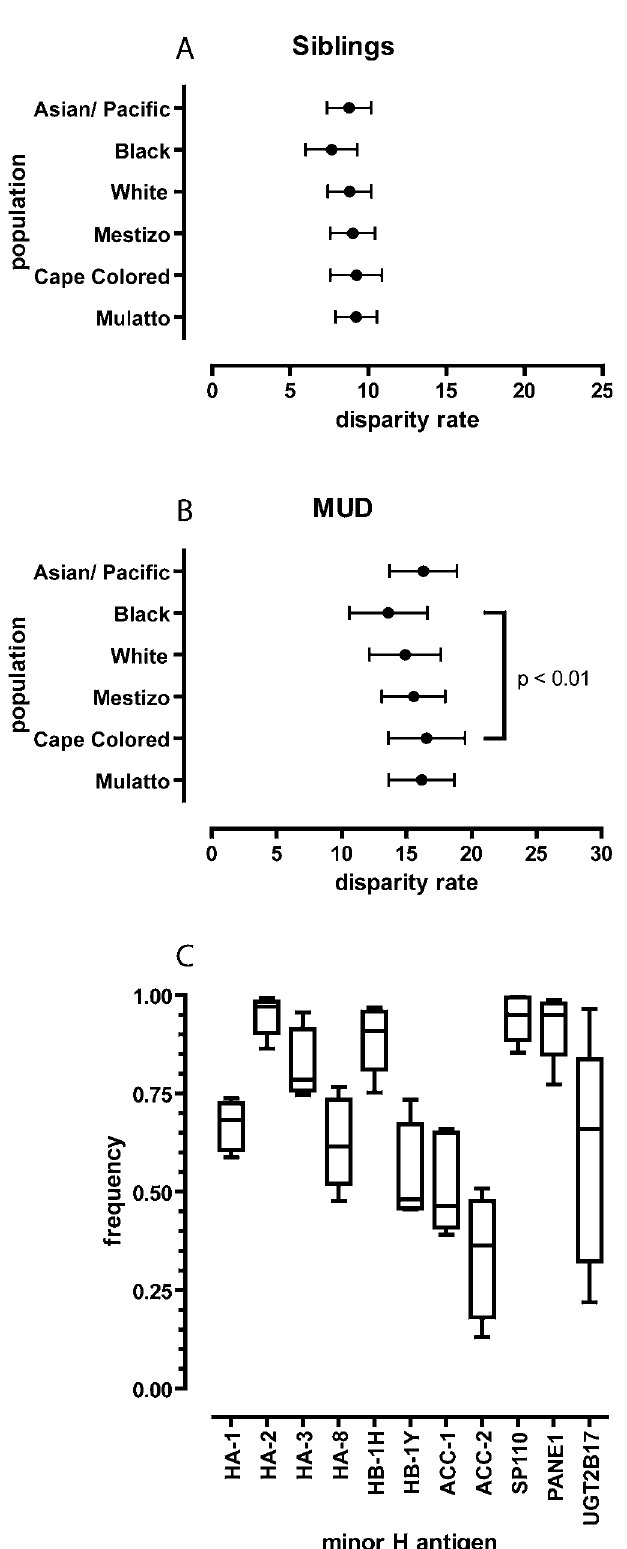
Figure 2. Estimated Minor H Antigen Disparity Rates Comparison for sib (A) and MUD (B) transplantations among six different ethnic populations. Data are depicted as the mean disparity rate of the ten analyzed minor H antigens and the standard error. (C) Variation in frequencies of the immunogenic minor H antigen phenotype per minor H antigen. doi:10.1371/journal.pgen.0030103.g002 PLoS Genetics |